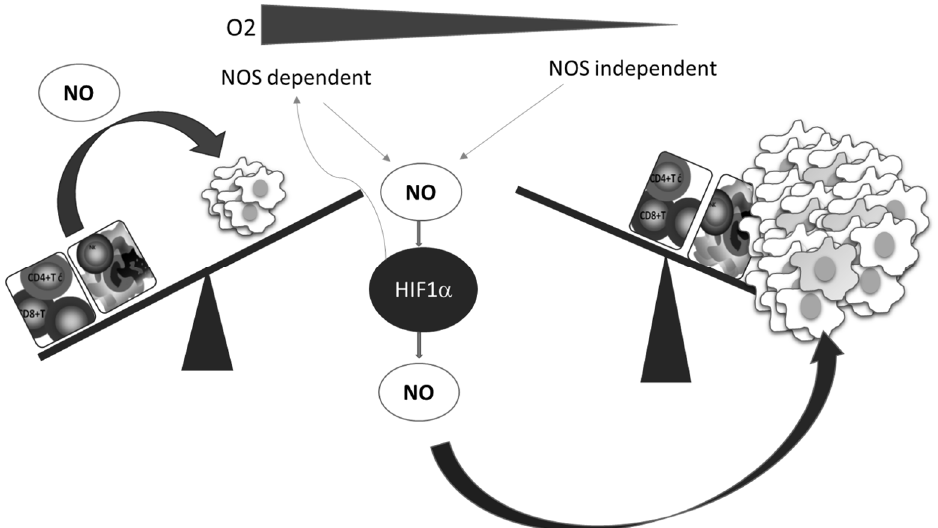
Figure 3. Oxygen deficiency and HIF-1–NO interplay favors tumor progression and immune escape. Decreased oxygen supply potentiates involvement of NO and HIF-1 α in the regulation of main cellular processes. These conditions preferentially support tumor cell proliferation and protumor activities in innate and tumor-specific